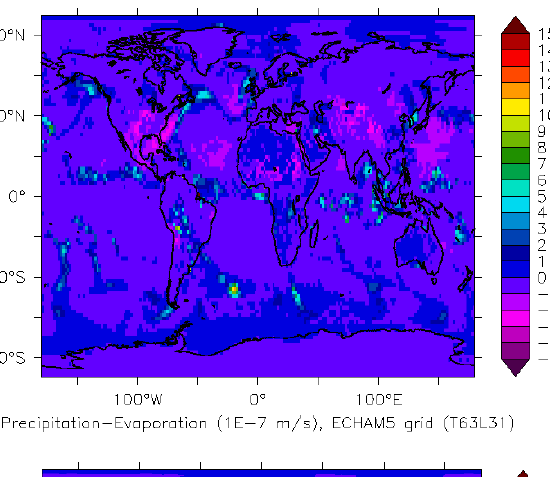
Fig. 4. Scatter plot of the time (seconds wall-clock) required to sim- ulate one month with the COSMOS-1.0.0 model (horizontal axis) and with the EMAC-MPIOM model with the same setup. The color code denotes the number of tasks used (for clarity the number of tasks used are shown also on the top of the points). In these simula- tions one task per core has been used. The regression line is shown in red and the result of the linear regression is denoted in the top left side of the plot. The constant bias of 58s has been subtracted from the